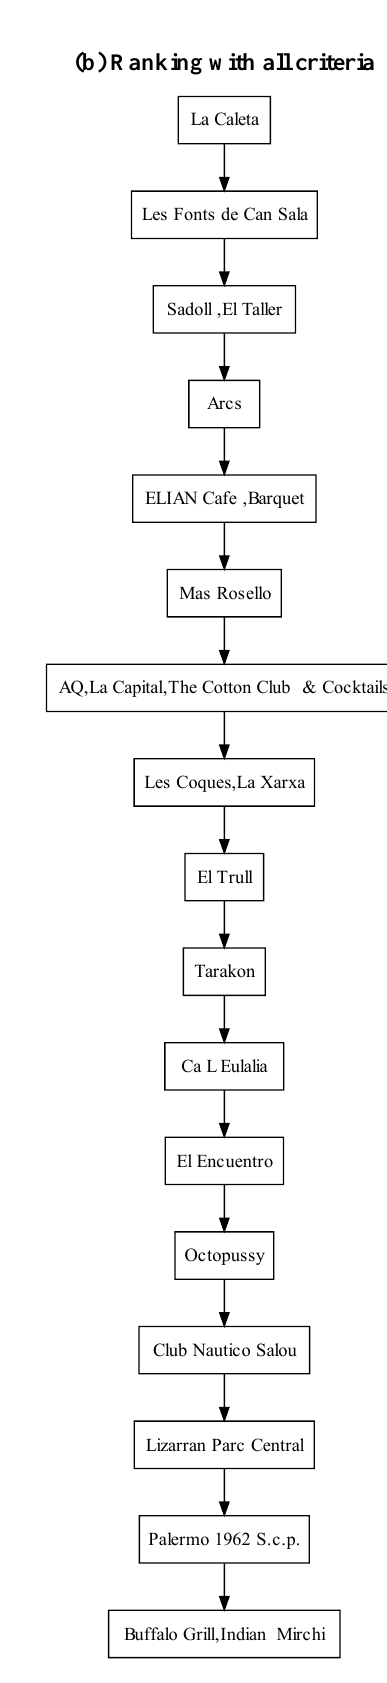
Figure 11. Profile 2: ranking